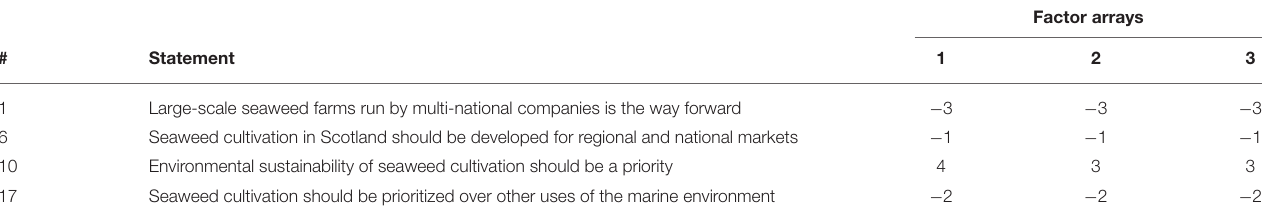
TABLE 6 | Agreement across factors: those statements that do not distinguish between any pair of factors.